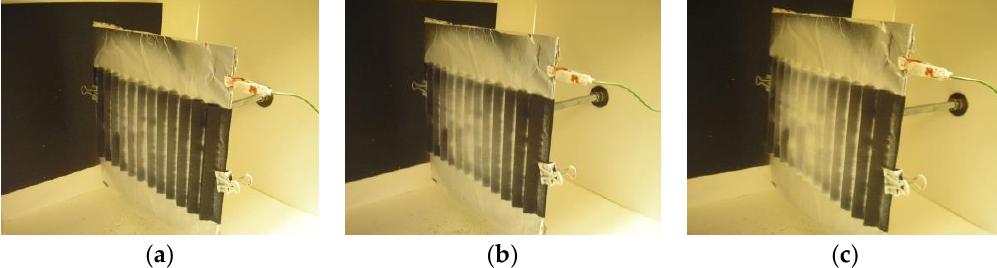
Figure 5. Photographs of 2 × 2 cm V-shaped folded collectors showing collected nanofibers after: ( a ) 15 min, ( b ) 30 min, and ( c ) 1 h of electrospinning.